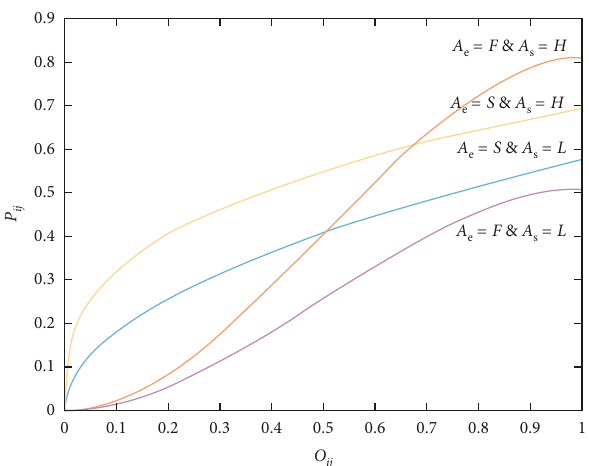
Figure 3: Correlation between overlapping rate and rework probability under different